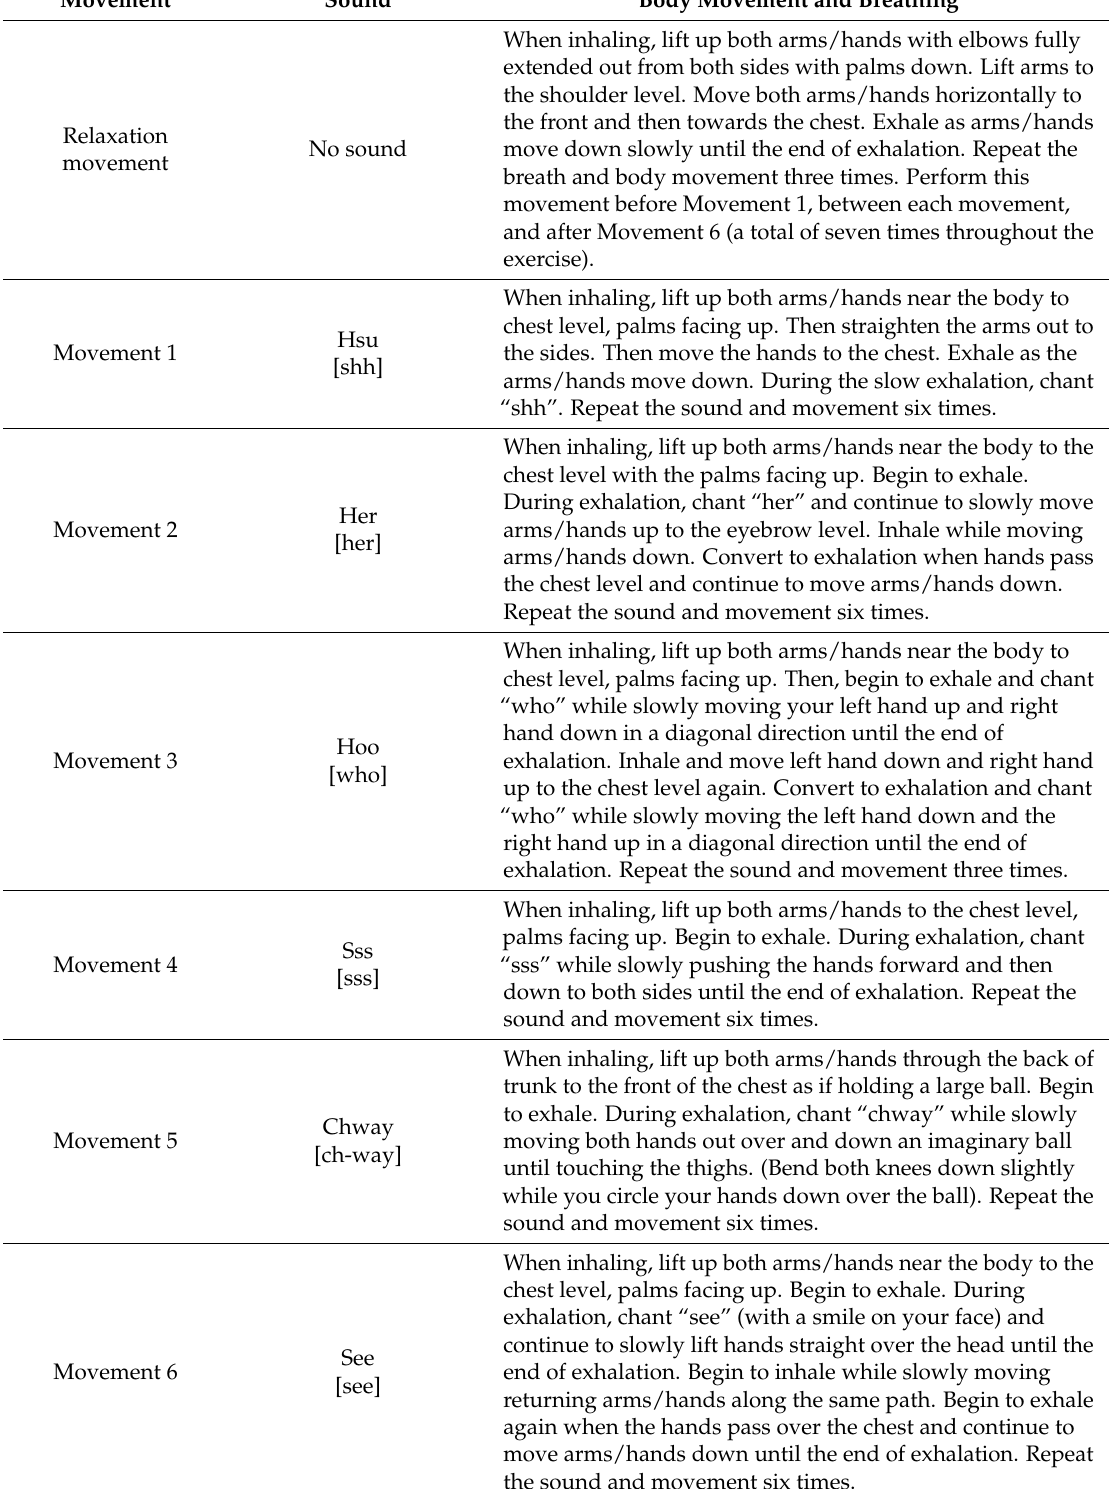
Table 2. Six healing sounds Qigong exercise